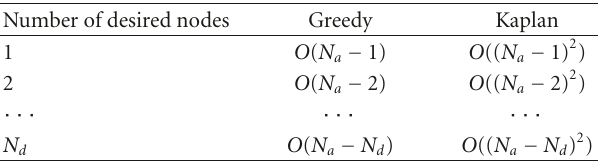
Table 1: Computational complexity of the node selection algo- rithms.